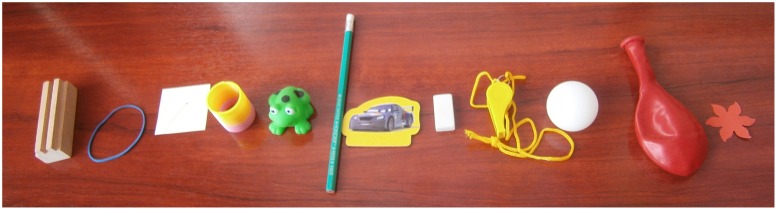
Sample of toy ranking. The star (right) is ranked highest and the wooden block (left) is ranked lowest.